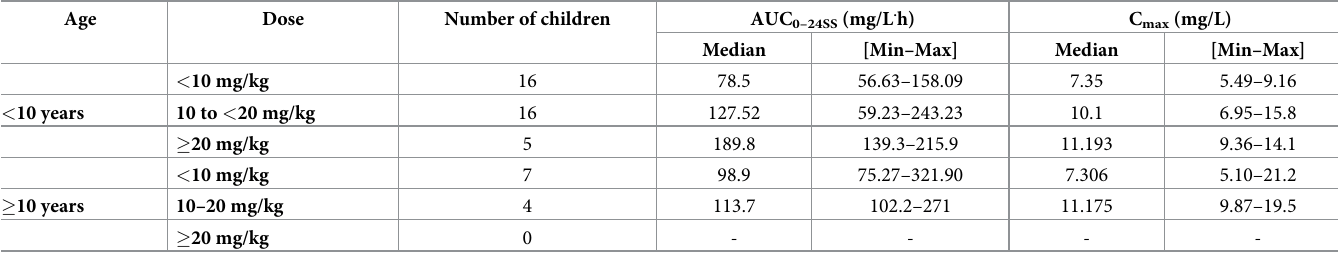
Table 3. Calculated linezolid AUC 0–24ss and C max from children with MDR-TB ( n = 48) stratified by age and daily dose. Age Dose